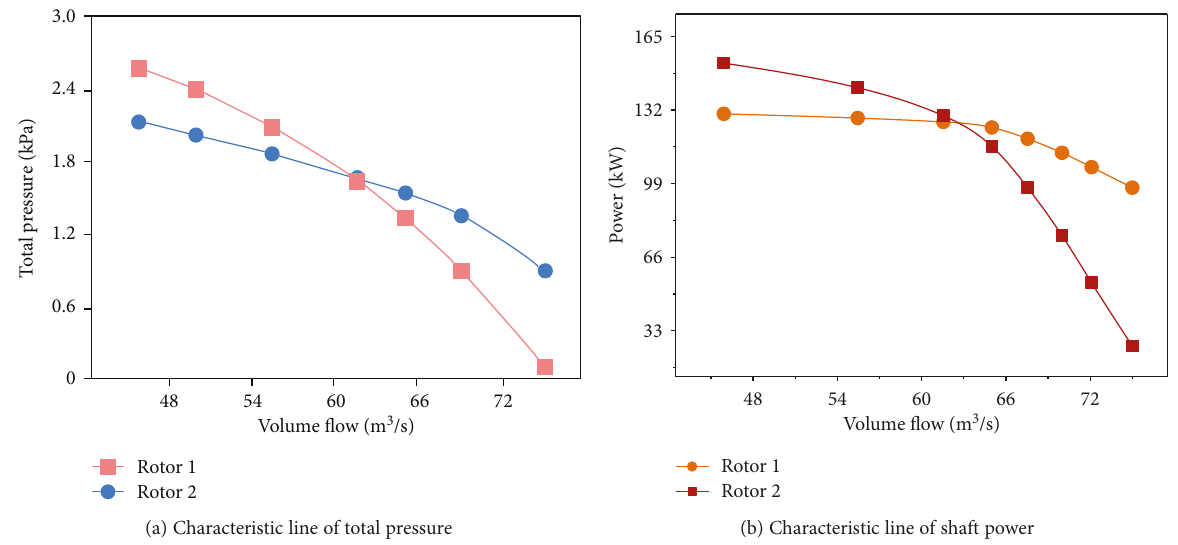
Figure 7: Total pressure and shaft power characteristic lines of two-stage rotors under design